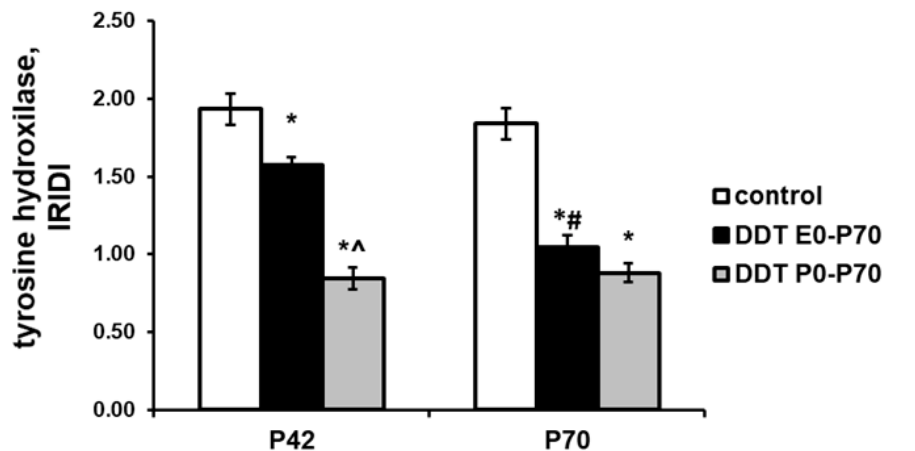
Figure 5. Changes in immunoreactivity intensity distribution index (IRIDI) for tyrosine hydroxylase in epinephrine-producing cells after developmental exposure to low doses of o,p’-DDT. Data are shown as mean ± S.E.M. P, day of postnatal development; p < 0.05 compared to the control (*), compared to the group DDT E0-P70(^), compared to P42 (#).